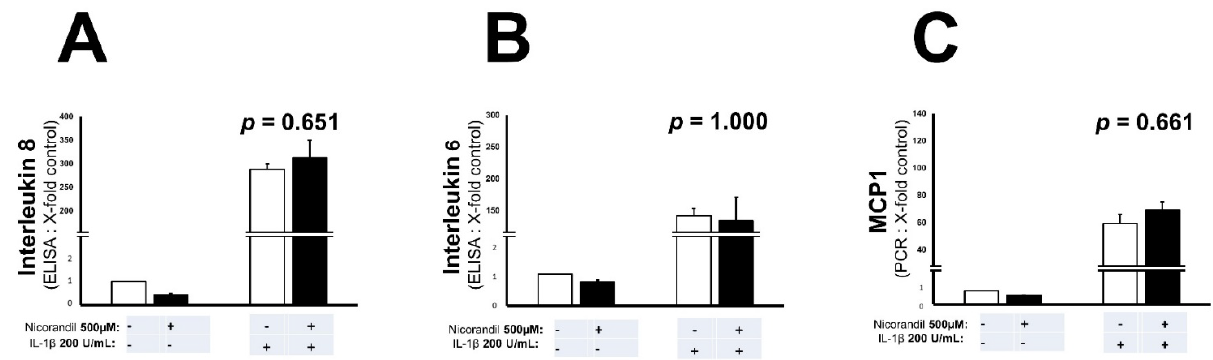
Figure 3. Pro-inflammatory cytokine production after nicorandil treatment. No significant reduction of IL8 ( A ) and IL6 ( B ) protein levels were observable in nicorandil (500 µ M) treated endothelial cells 8 h after stimulation with IL-1 β . Furthermore, there was no change in MCP-1 mRNA levels 2 h after stimulation with IL-1 β , as determined by real-time PCR ( C ). All values given represent means ± standard deviations; the statistical significance of p ≤ 0.05 was considered signifi- cant.